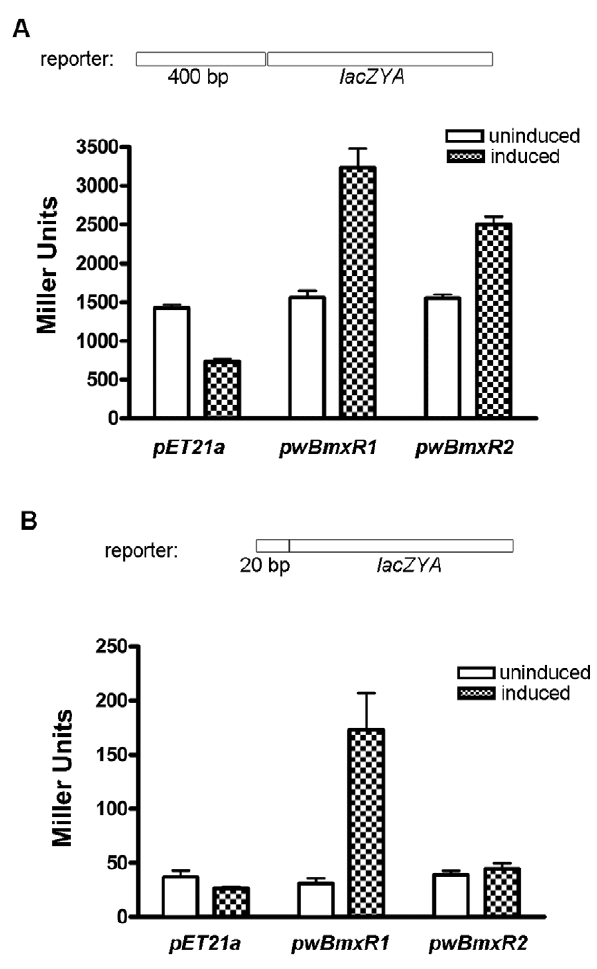
Figure 7. w BmxR1 and w BmxR2 positively regulate the transcription of ribA lacZ reporter. b –galactosidase assays were used to measure the transcriptional activities of lacZ reporter constructs. E. coli strain C2566 transformed with the reporter plasmid and protein expression vector pET21a , or pwBmxR1 , or pwBmxR2 were tested. b –galactosidase assays were performed on induced (IPTG) and un-induced samples. Miller units are shown as mean 6 standard deviations from 3 replica experiments. The ribA promoter region containing 400 bp (A) or 20 bp minimal binding sequence (B) were fused to a promoter-less lacZ and cloned into low copy plasmid pACYC184 to generate the reporter plasmid. doi:10.1371/journal.pone.0051597.g007 ( wBm0185 ), ribB ( wBm0312 ) indicating that the entire pathway is present in w Bm (Fig. 8A). Further analysis was performed on ribA to determine the relative expression of the gene throughout the parasite life cycle. qRT-PCR showed expression of ribA (ratio of ribA to 16S rRNA) in all stages examined (adult female and male worms, microfilariae, third- and fourth-stage larvae) with lowest levels in microfilariae (Fig. 8B). RT-PCR experiments using adult female B. malayi RNA showed ribD , ribE , and ribB genes are also expressed (data not shown).